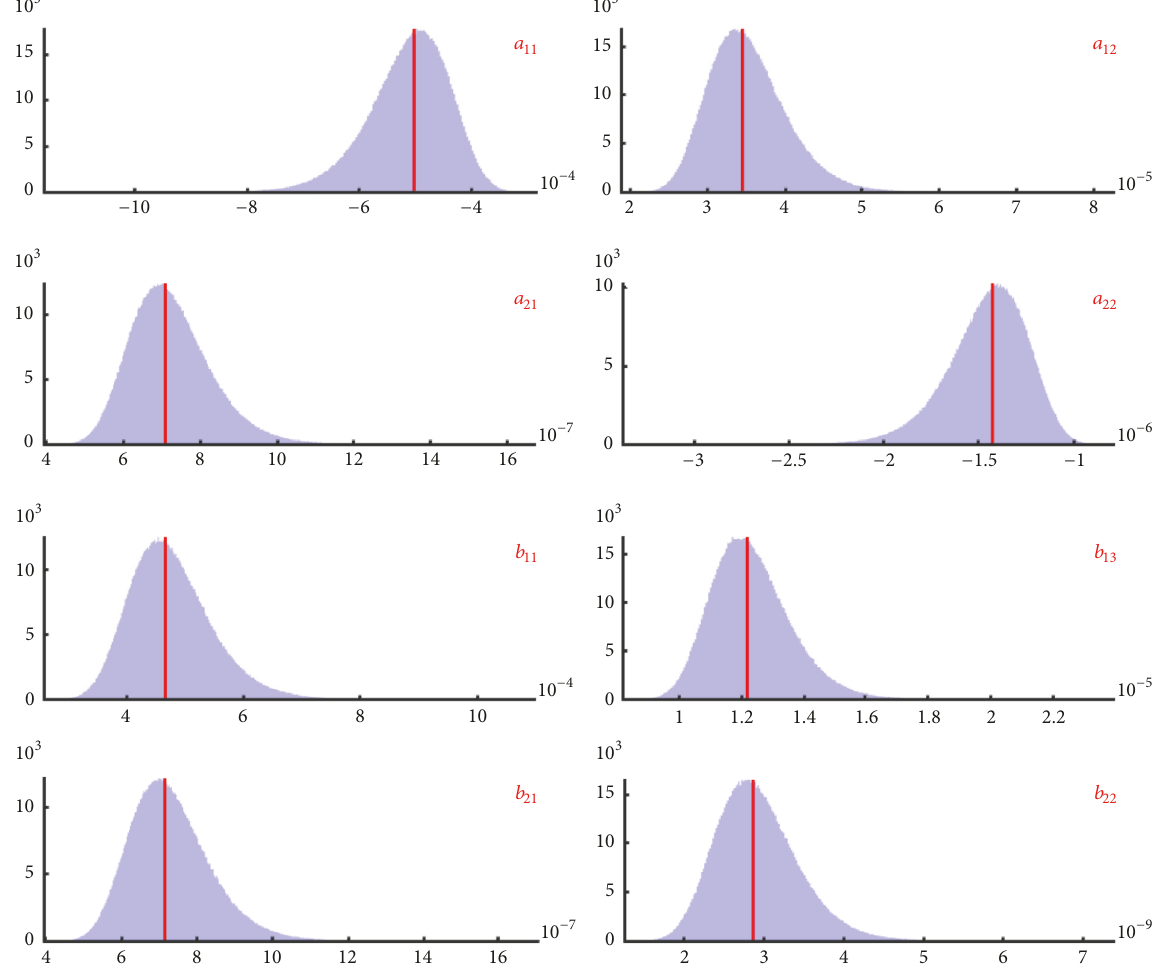
Figure 4: Histograms, RC to SS transformation. Table 1: RC to SS transformation